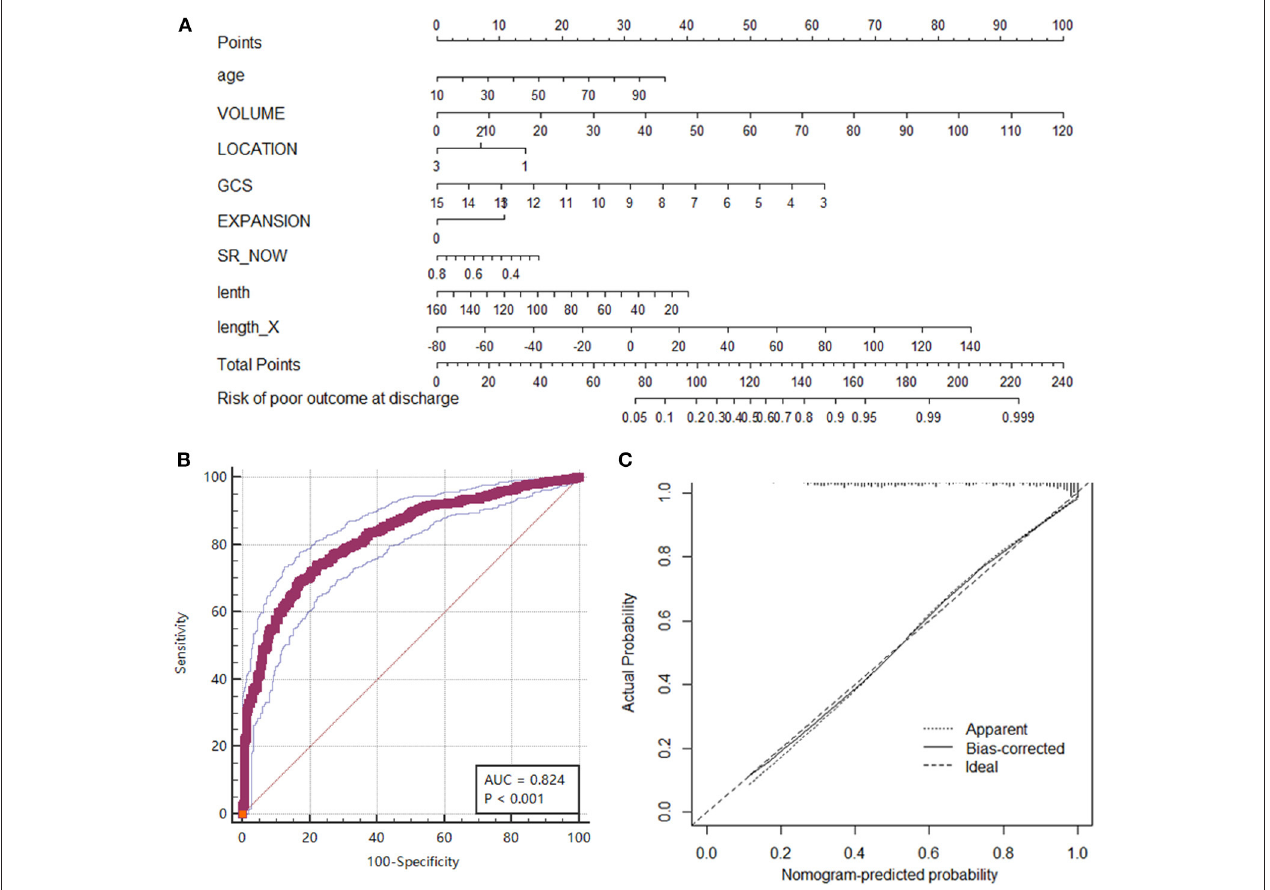
FIGURE 4 | Nomogram of the prognostic model for predicting poor outcomes (GOS ≤ 3) at discharge. (A) The nomogram was developed from a multivariable logistic regression model based on age, volume, location, GCS, hematoma expansion, initial SR index, diameter lengths, and length change in the LR direction. (B) ROC curve of the nomogram representing the discrimination performance of the model. (C) Calibration curve of nomogram. A calibration curve depicts the calibration of a model in terms of the agreement between the predicted risk of a poor outcome and the outcome actually observed. The Y-axis represents the actual poor-outcome rate. The X-axis represents the predicted poor-outcome risk. The diagonal dotted line represents a perfect prediction by an ideal model. The solid black line represents the performance of the nomogram, where a closer fit to the diagonal dotted line represents a better